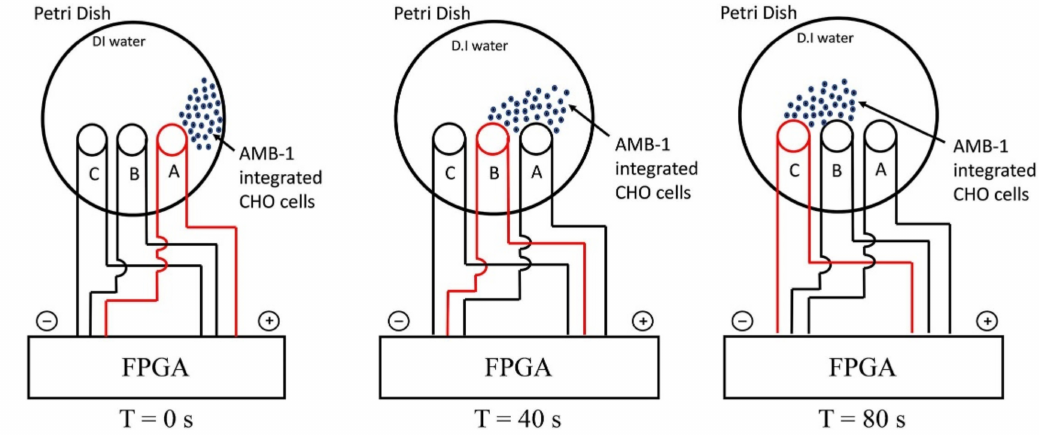
Figure 20. Schematic illustrating the experimental setup for directional control displaying the movement of AMB-1-integrated CHO cells from coil A to coil C. The charged coil is shown in red, and the AMB-1-integrated CHO cells are displayed as blue dots. Reprinted from [240], license CC BY 4.0.